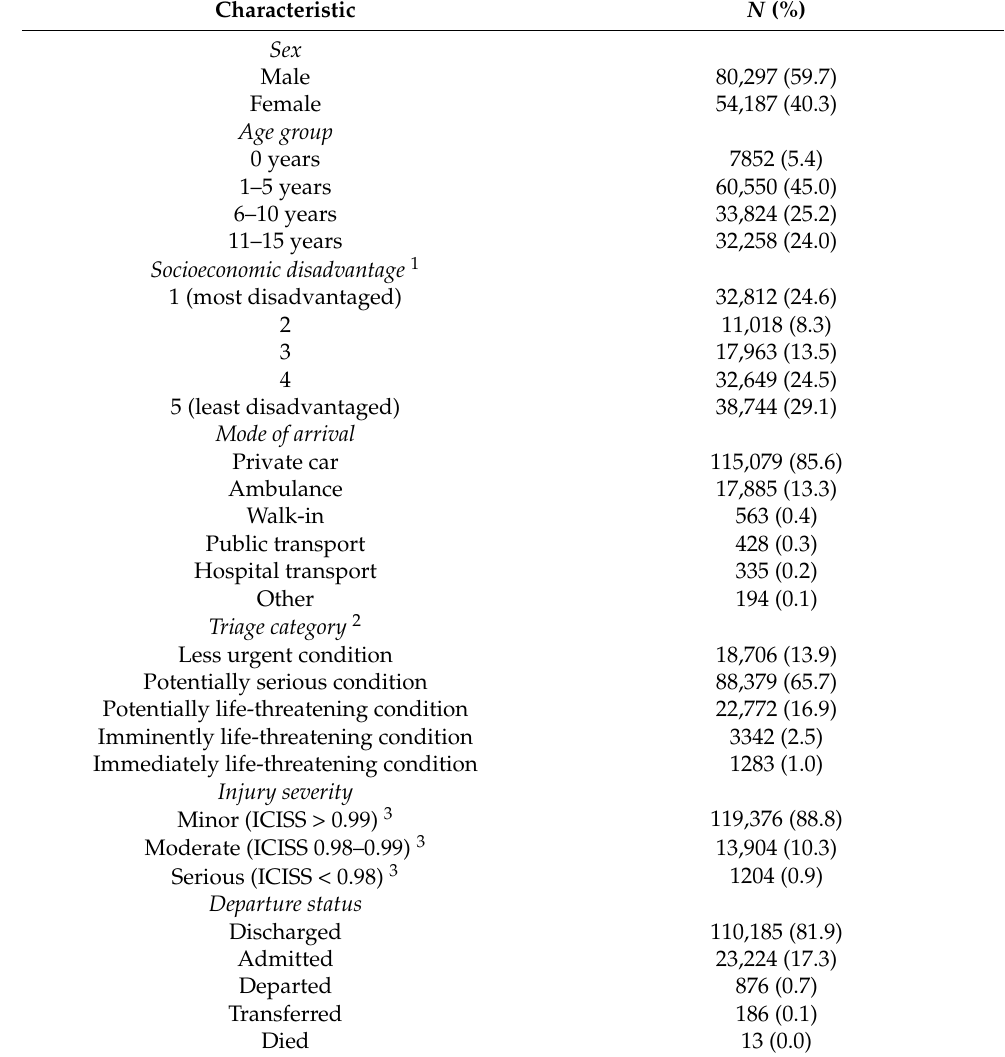
Table 1. Characteristics of paediatric injury-related ED presentations, 1 January 2010 to 31 December 2019 ( N =